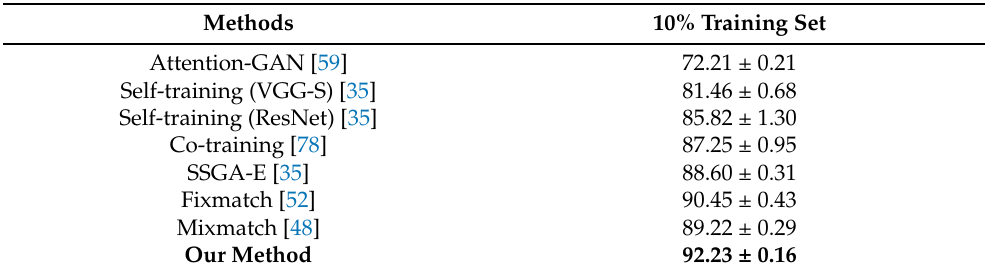
Table 5. Overall accuracy and standard deviations (%) of the proposed method and comparison methods on NWPU-RESISC45